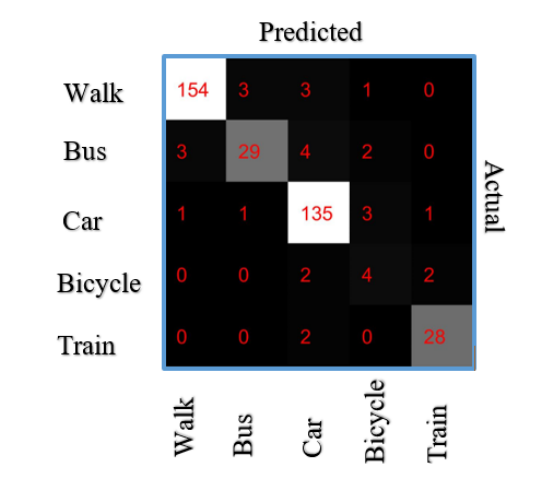
Figure 9 . Confusion matrix for linear SVC classifier